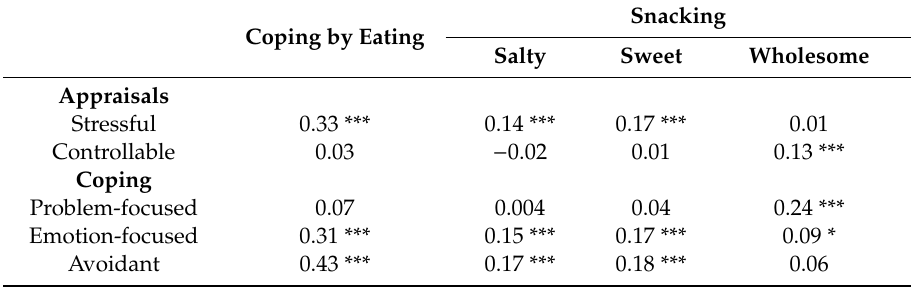
Table 5. Correlations between appraisals and general coping strategies with coping by eating and snacking behaviors ( n = 680). Snacking Coping by Eating Salty Sweet